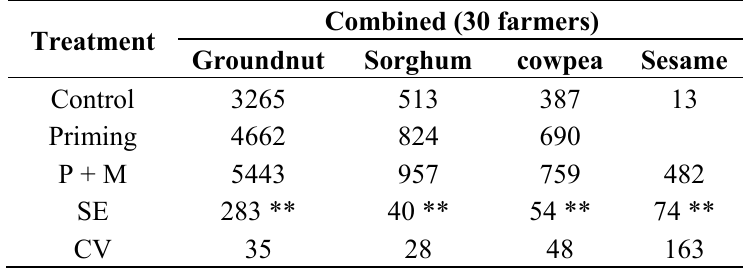
Table 14. The effect of seed priming and micro-dosing on gross margin in on-farm farmer managed